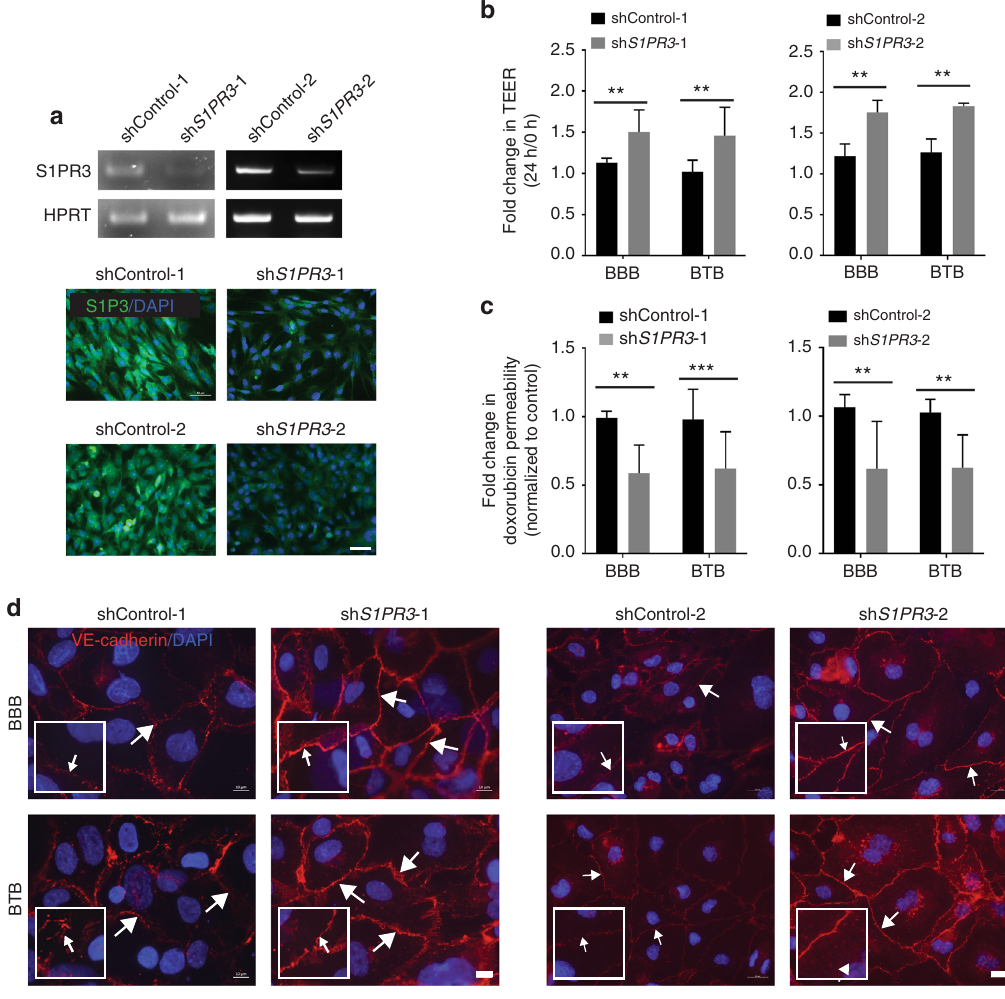
Fig. 6 Knockdown of astrocytic S1PR3 strengthened the BBB and BTB in vitro. Immortalized human astrocytes were transduced with either control shRNA (shControl-1, shControl-2) or sh S1PR3 (sh S1PR3 -1, sh S1PR3 -2), and used in TEER and permeability assays of the BBB and BTB (see legend to Fig. 5). a RT- PCR for S1PR3 mRNA (top) and immuno fl uorescent staining (bottom) for S1P3 protein (green). Nuclei are DAPI stained (blue) (scale bar = 50 μ m). b TEER assays using either shControl-1, -2 or sh S1PR3 -1, -2 astrocytes in the cultures. S1PR3 knockdown elevated TEER at 24 h, indicative of a tighter BBB and BTB, ( n = 6). c Permeability of 100 µ g mL − 1 doxorubicin from luminal to abluminal side of the inserts in the BBB and BTB, ( n = 6). Astrocytic S1P3 knockdown (using sh S1PR3 -1 and sh S1PR3 -2) reduced permeability. d Staining of endothelial cell monolayers in TEER assays for VE-cadherin (red) demonstrating increased membrane staining (white arrows) when sh S1PR3 -1, -2 astrocytes were included. Nuclei were DAPI stained (blue) (scale bars = 10 μ m for set-1 and 20 μ m for set-2). For ( b ) and ( c ), Mann – Whitney statistical analysis was performed. Graphs represent the median and the error bars the 95% con fi dence intervals, from independent transwell BBB/BTB cultures ( n ) from multiple experiments. ** P < 0.01, *** P <